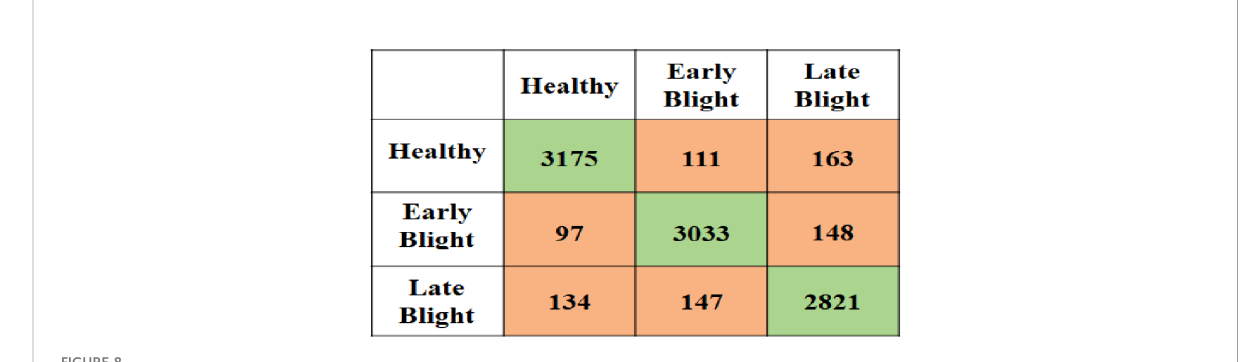
FIGURE 8 Proposed model confusion matrix for Potato plant disease classi fi cation.